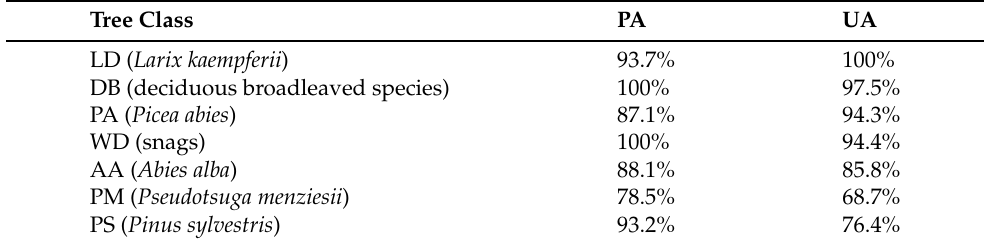
Table 6. Recognition of tree classes according to Producer’s Accuracy (PA) and User’s Accuracy (UA). Tree Class